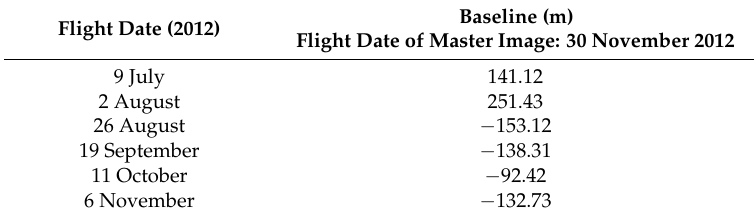
Table 2. Baseline